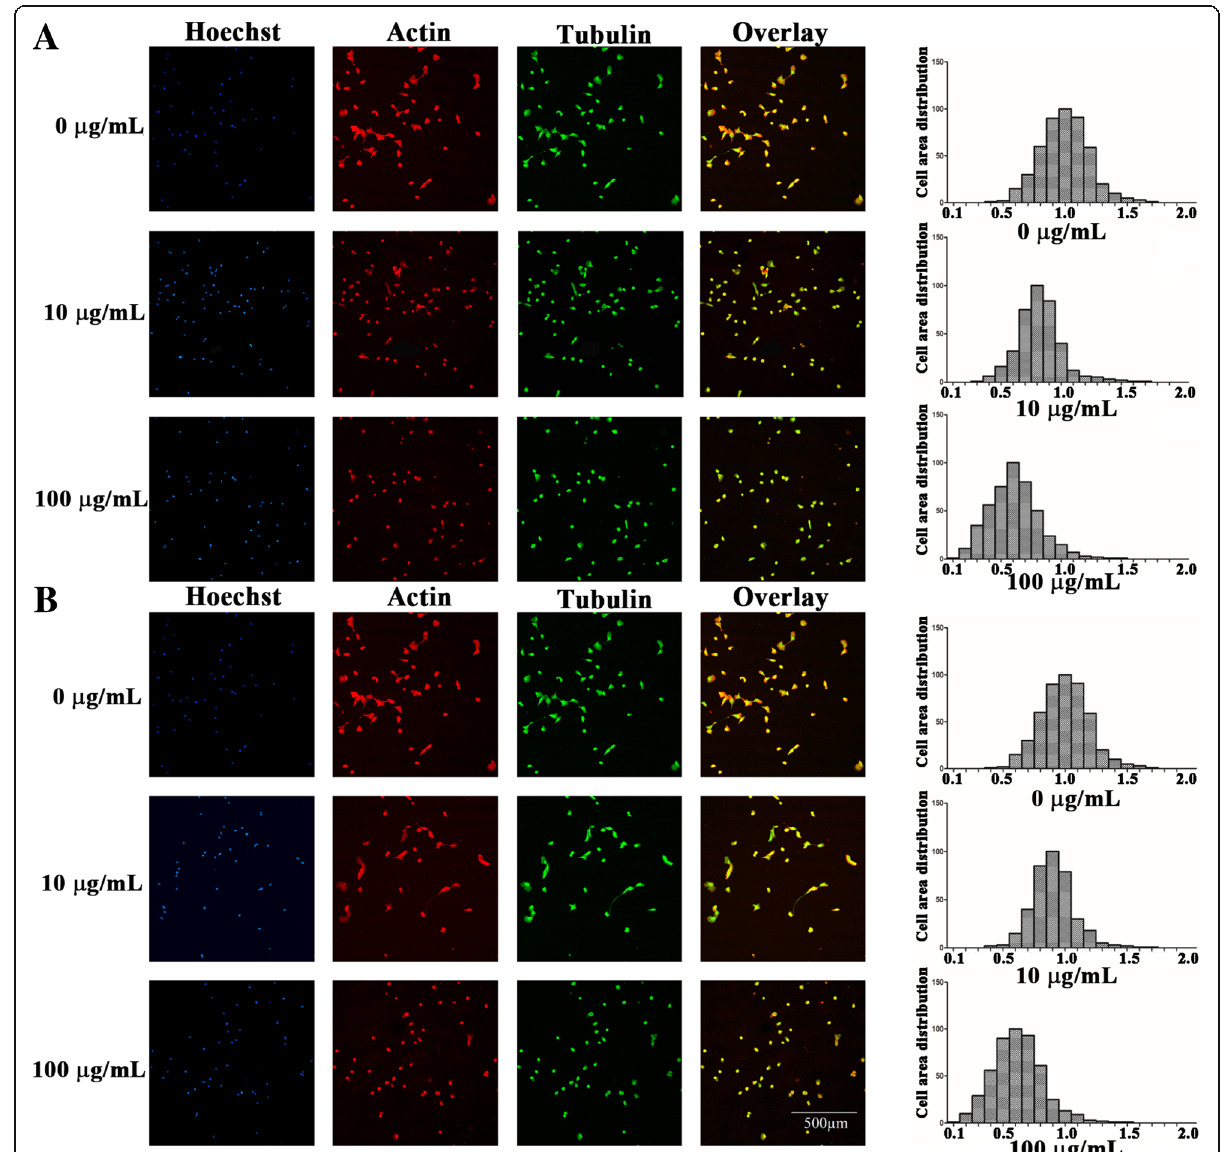
Fig. 5 TiO 2 and ZrO 2 NP-induced cell area changes in 3T3-E1 cells. After the 3T3-E1 cells were treated with the TiO 2 ( a ) and ZrO 2 ( b ) NPs at concentrations of 10 and 100 μ g/mL for 24 h, the cells were loaded with tubulin (green), actin (red), and Hoechst 33342 (blue). The cell morphology was observed based on the alterations of the actin (red) and tubulin systems (green), and the cell area distribution changes were